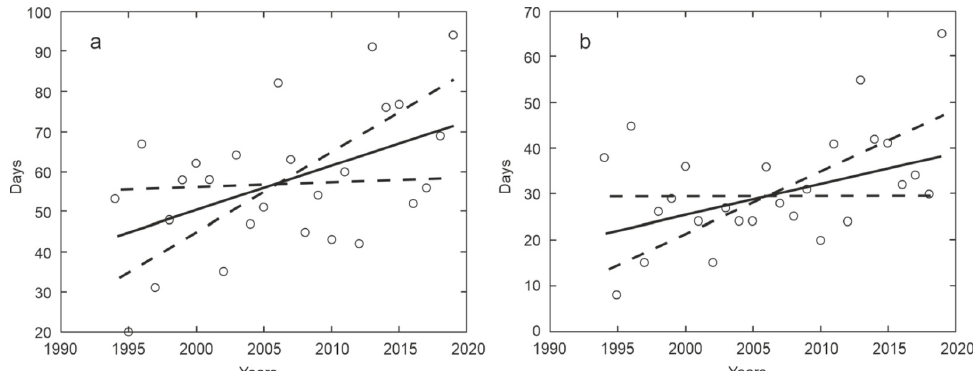
Figure 2. Number of days with positive air temperature ( a ), and with liquid or mixed precipitation ( b ) in November–April in 1994–2020. Solid lines—linear trends, dashed lines—95% confidence interval.